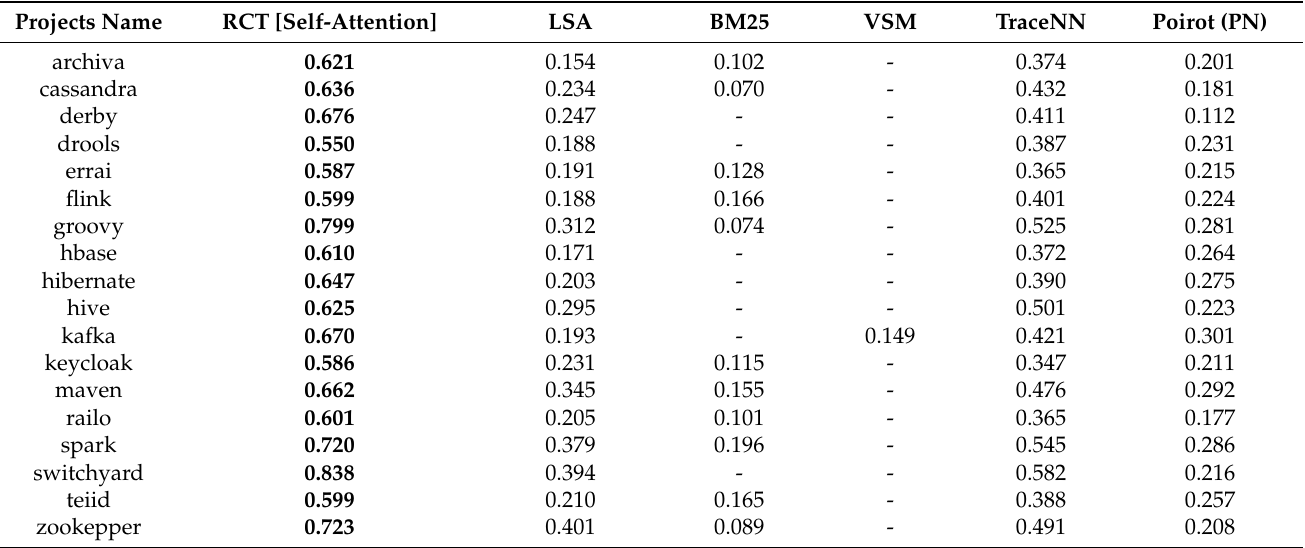
Table 7. Performance comparison of RCT with existing techniques for constructing traceability links under Recall